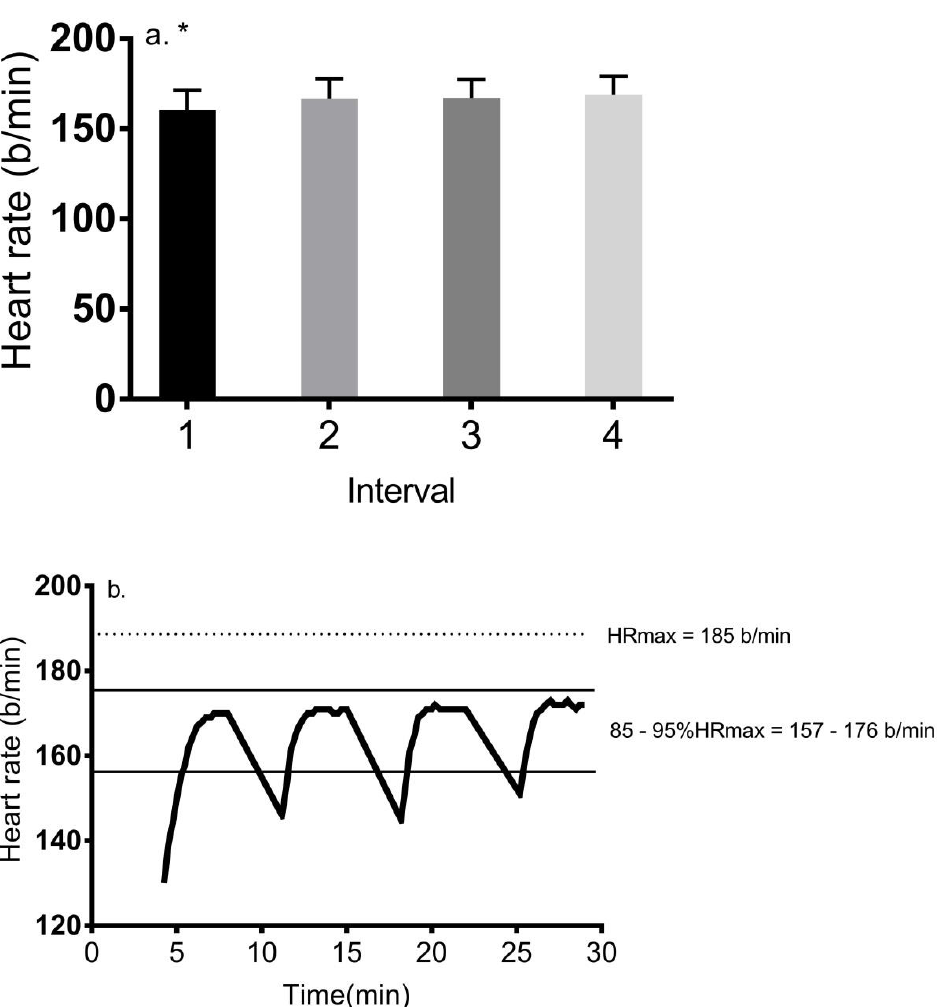
Figure 1. ( a ) Mean heart rate response to each of the four intervals during the 4 × 4 protocol (mean ± SD). * = p < 0.05 for interval 1 versus intervals 2–4; ( b ) overall HR response during the 4 × 4 protocol for all 39 participants. Note that minutes 4–8, 11–15, 18–22, and 25–29 represent the four intervals of the session. The 2 lines represent the HR zone from 157 to 176 b / min, representing 85–95% HR max. Table 2. Time spent between 85 and 95% HR max during the 4 × 4 regimen (mean ± SD). Time spent between 85 and 95% HR max increased during the session ( p < 0.001), and post hoc Interval Number Time Spent between 85 and 95% HR Max (min)